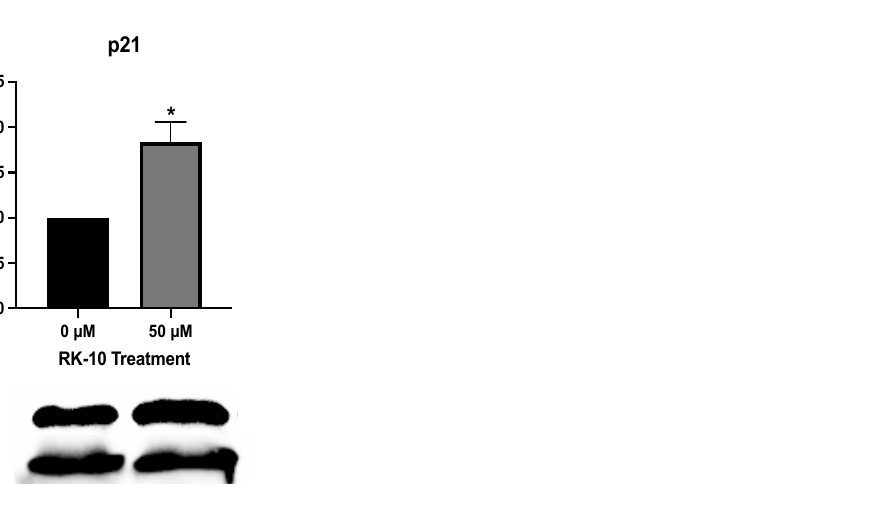
Figure 8. RK-10 induces p21 expression in MDA-MB 231 cells. MDA-MB 231 cells were cultured and treated with 0 or 50 µM of RK-10 for 24 h. Afterwards, the cells were assayed by immunoblotting to examine the expression levels of p21 and GAPDH (loading control). Student’s t -tests were performed, and treatments were compared to the DMSO control. Results are expressed as the means ± SDs (* p < 0.05), and data are representative, from one of at least three independent experiments.